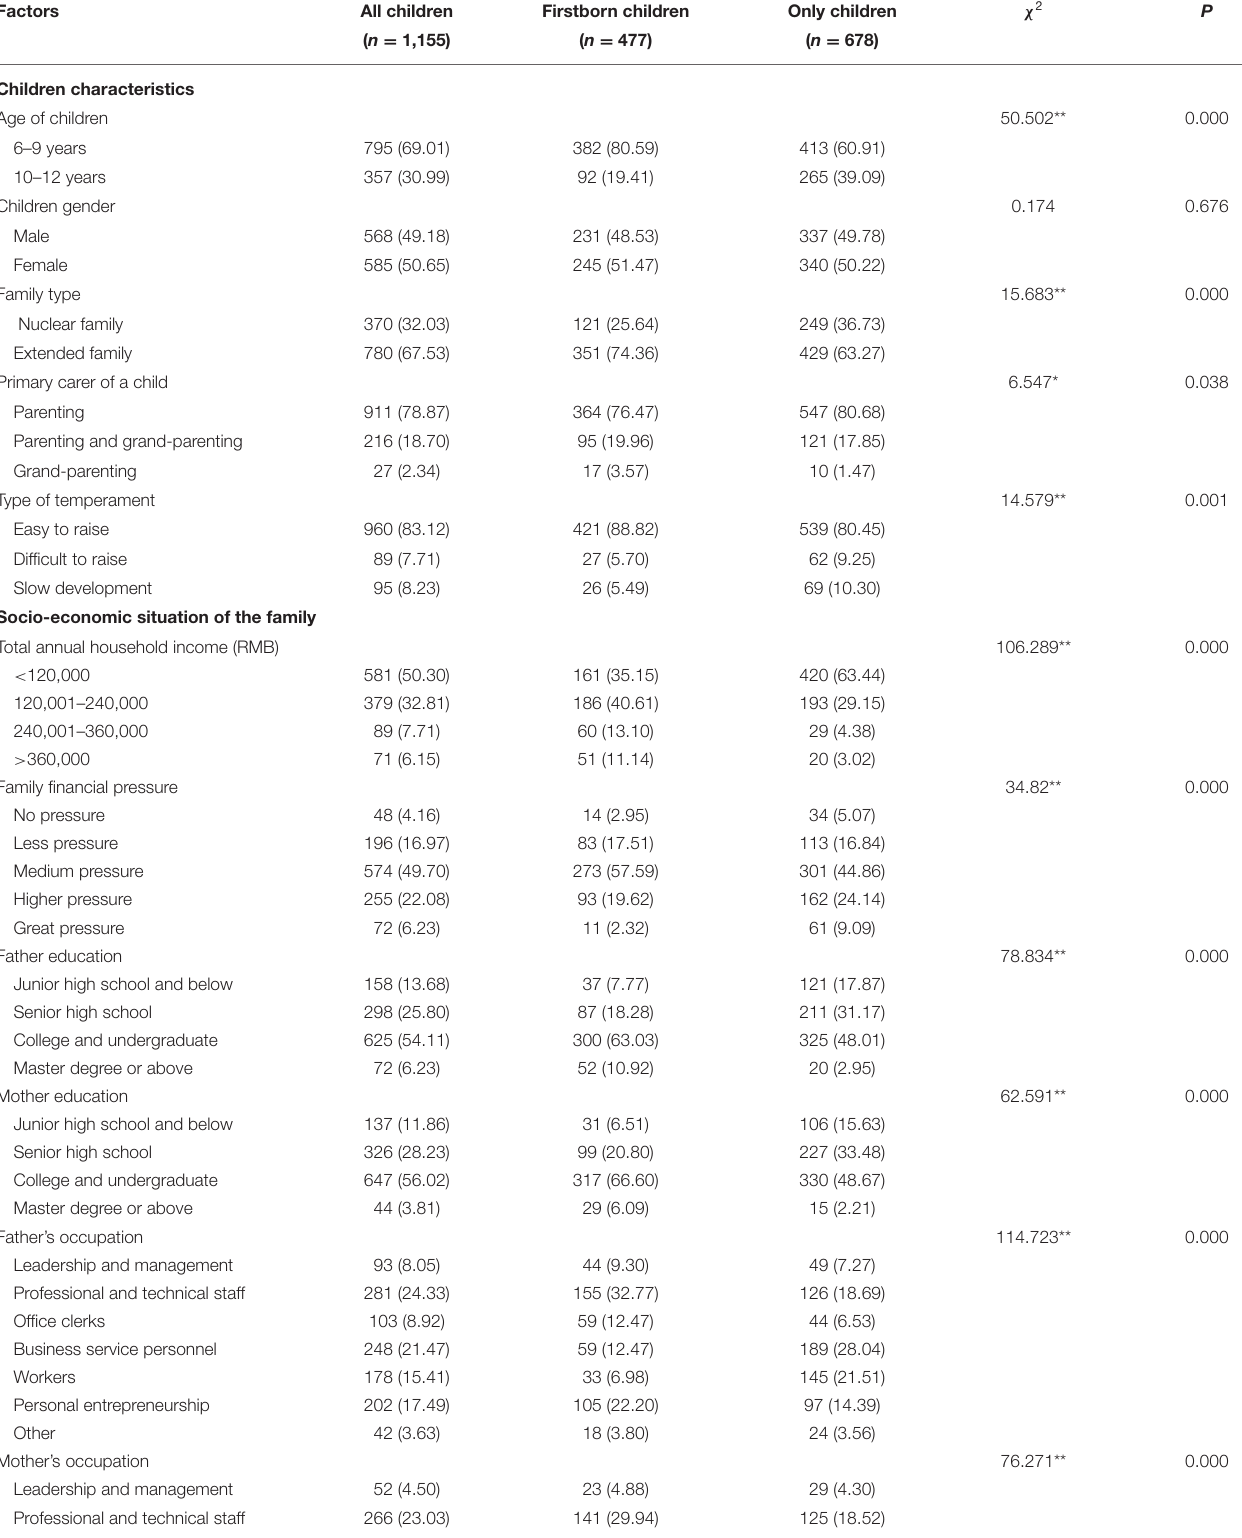
TABLE 1 | Comparison of children characteristics, socio-economic characteristics, family relationship between firstborn and only children, n (%), Chi-square test. Factors All children Firstborn children Only children χ